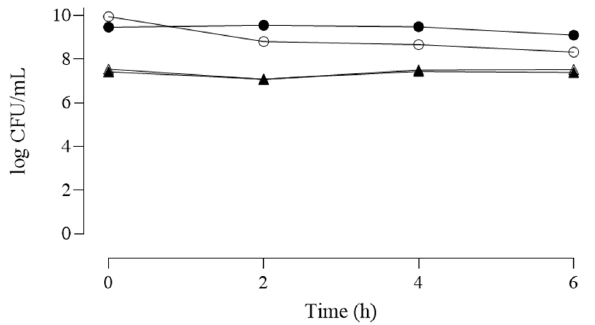
Figure 6. Concentrations (mean ± standard deviation, n = 2) of lactic acid bacteria ( ● ) and yeasts. ( ▲ ) in the FM-S sample and of lactic acid bacteria ( ⭘ ) and yeasts ( △ ) in FM-B during exposition to simulated gastrointestinal conditions for 2 h (T2, gastric phase), 4 h (T4, enteric phase 1), and 6 h (T6 enteric phase 2).